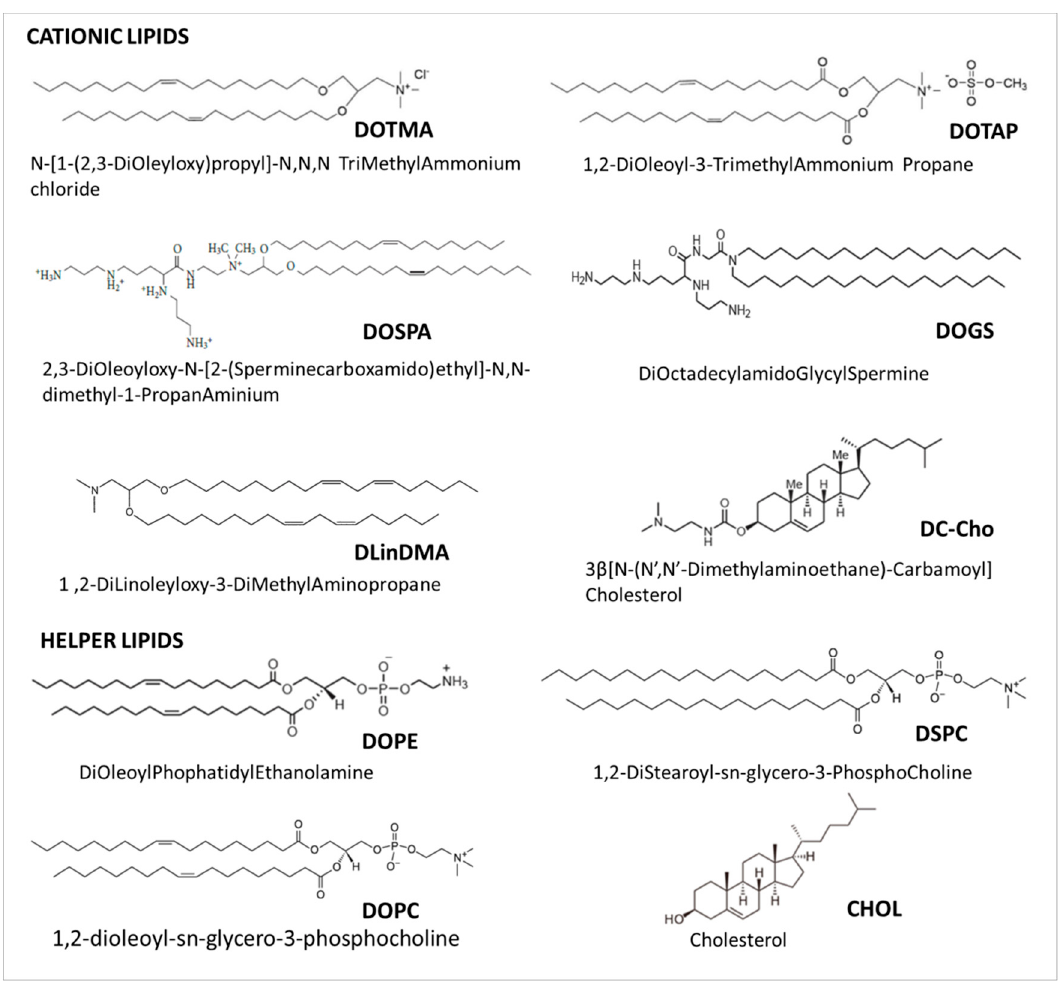
Figure 3. Structures of cationic and helper lipids used as components of various siRNA liposomal delivery systems.